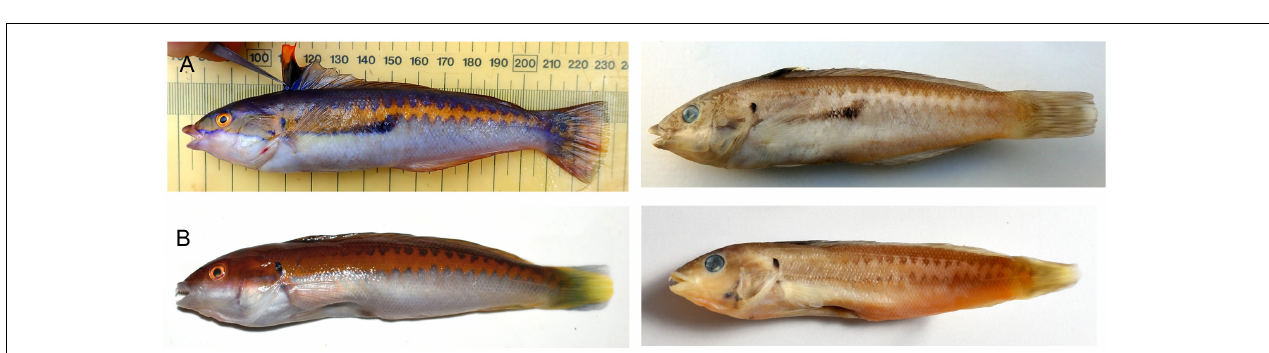
FIGURE 4 | Panels (A–D) show photographs of specimen CFM-IEOMA 7429 from Cala Sant Vicenç, Mallorca, Balearic Islands, Mediterranean Sea, showing the primary livery of Coris julis . (A) Swimming before entering in the trap; (B) just after being caught, out of water; (C) back in water again before anesthesia; (D) just after death; (E) after preservation in formalin. Panel (F) shows the preserved coloration of neotype of Labrus perdica Niebuhr (1775) SMNS 11609 from Greece.